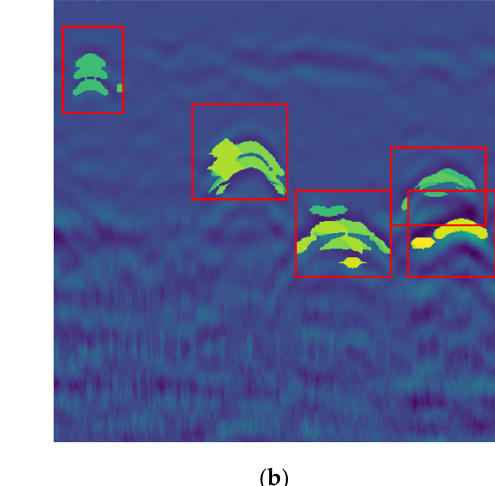
Figure 17. Results of our segmentation method. ( a ) The example in Figure 16. ( b ) The output from the symmetry test labeling with different colors. ( c ) The result of the hyperbola fitting on ( b ). ( d ) is the result of the hyperbola fitting showing on ( a ).